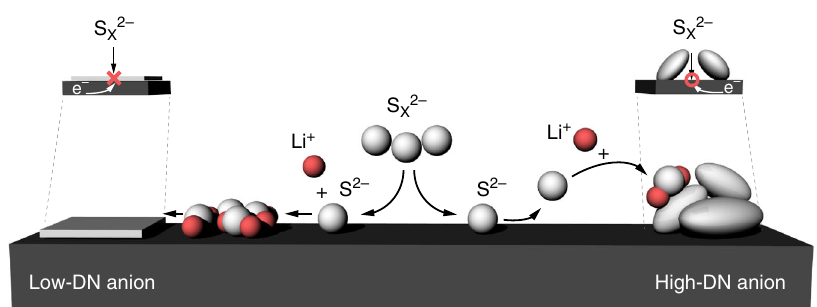
Fig. 7 Proposed mechanisms for the different lithium sul fi de growth behaviors. Based on the solubility of lithium sul fi de (Li 2 S) in an electrolyte medium, high-donor number (DN) anions can induce the three-dimensional growth of Li 2 S, effectively delaying the